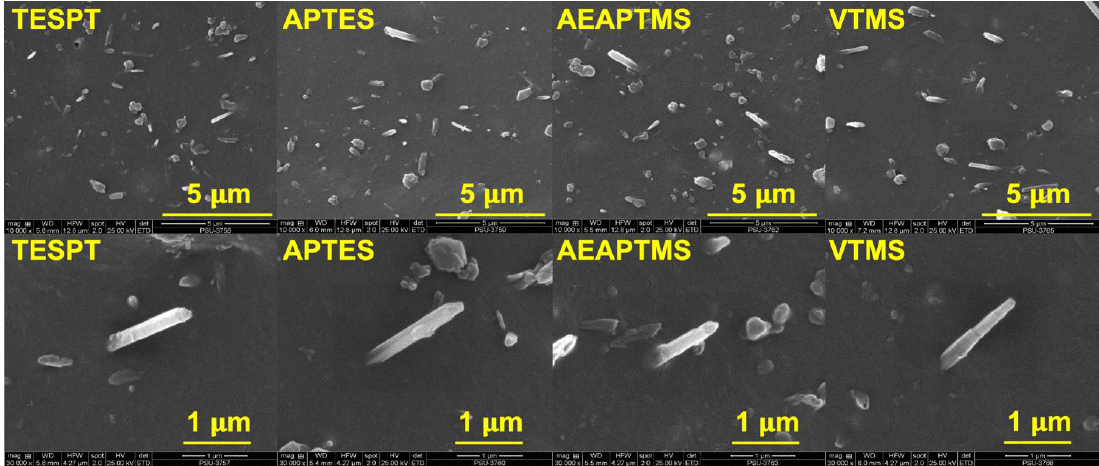
Figure 10. SEM images at 10,000× (top) and 30,000× (bottom) of NR/HNT composites filled with silane coupling agents. silane coupling